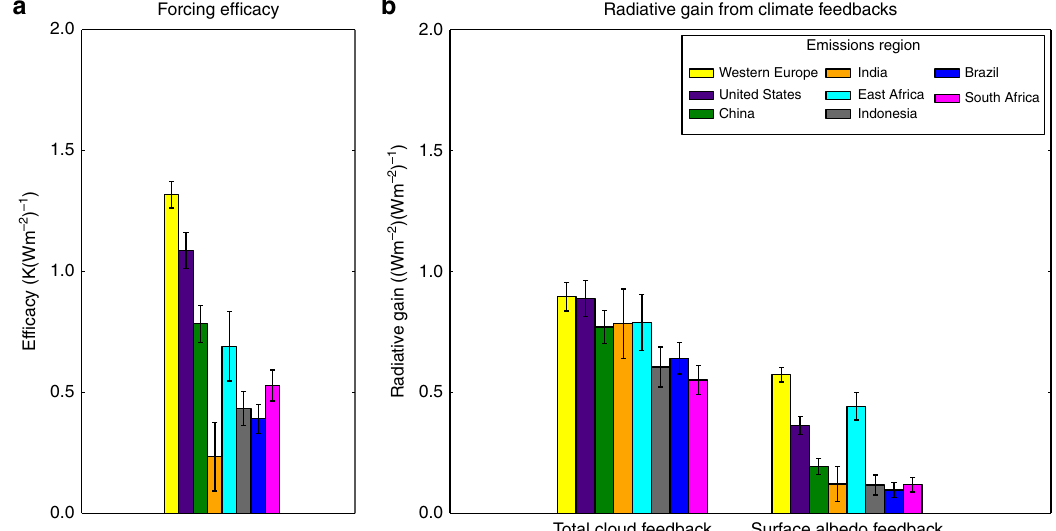
Fig. 4 Radiative feedbacks versus forcing ef fi cacy. Differences in forcing ef fi cacy ( a ) are largely explained by variance in the global-mean radiative gain from surface albedo and cloud feedbacks ( b ) — i.e., the additional top-of-atmosphere fl ux change from the feedback due to a unit of effective radiative forcing — across emissions regions. Error bars capture the standard